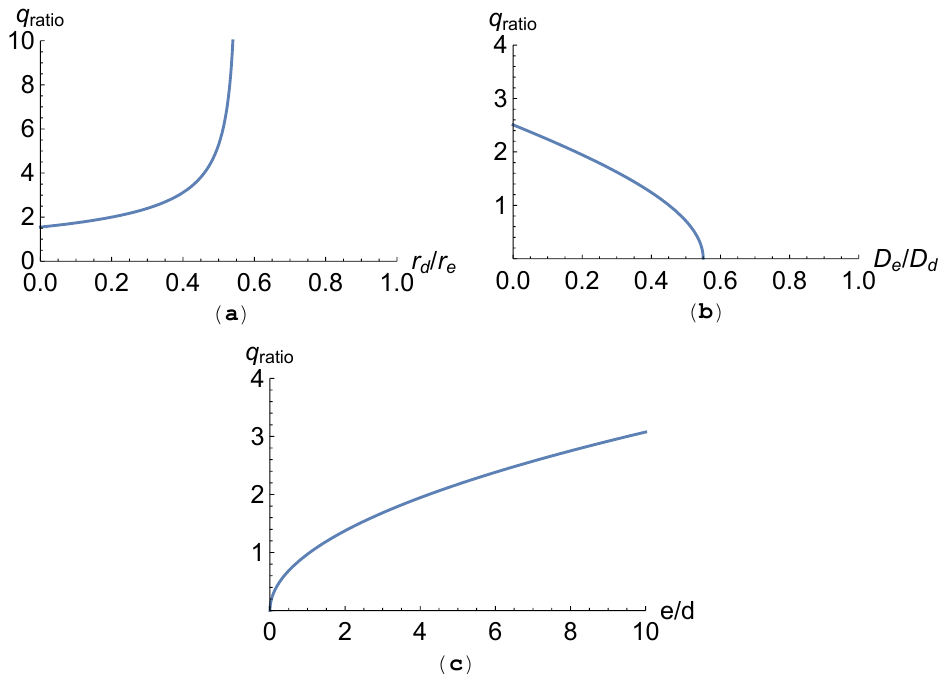
Figure 7. Parameter sweeps of Equation (73). We fix D and m in ( a ), r and m in ( b ), and r and D in ( c ). When fixed, parameters take the values r = 0.2/1.1, D = 0.3/1.5, m =